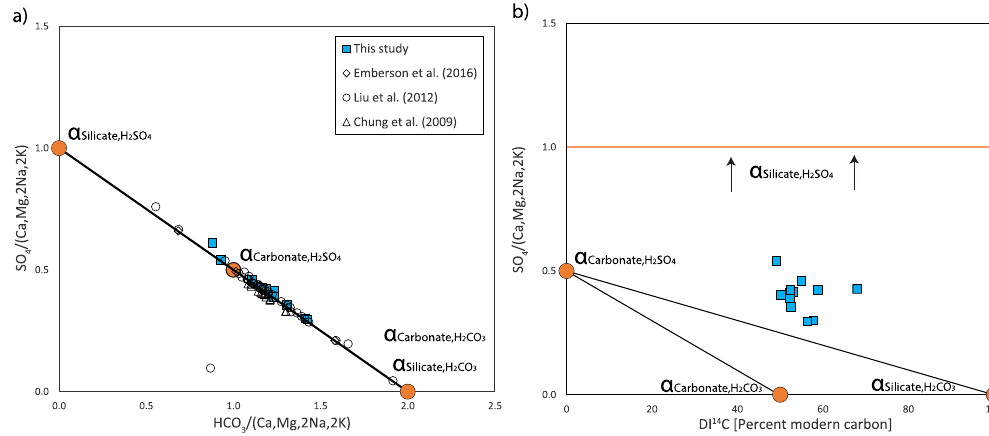
Figure 2. Mineral weathering end-member mixing. ( a ) Mineral unit-normalised sulphate versus bicarbonate abundance. The Gaoping River data collected over multiple years in relation to the quaternary end-member mixing line. Literature data points where ionic compositions reflect incursion of seawater plot away from the quaternary mixing line. One data point from this study (datapoint with highest mineral unit normalised sulphate) deviated from the mixing line due to high ammonium amounts that are attributed to anthropogenic inputs and therefore wasn’t considered further in this study. Removing these anomalies, the data from this study correlates with R 2 = 0.99, and for all studies with R 2 = 0.99. ( b ) Mineral unit-normalised sulphate versus pMC